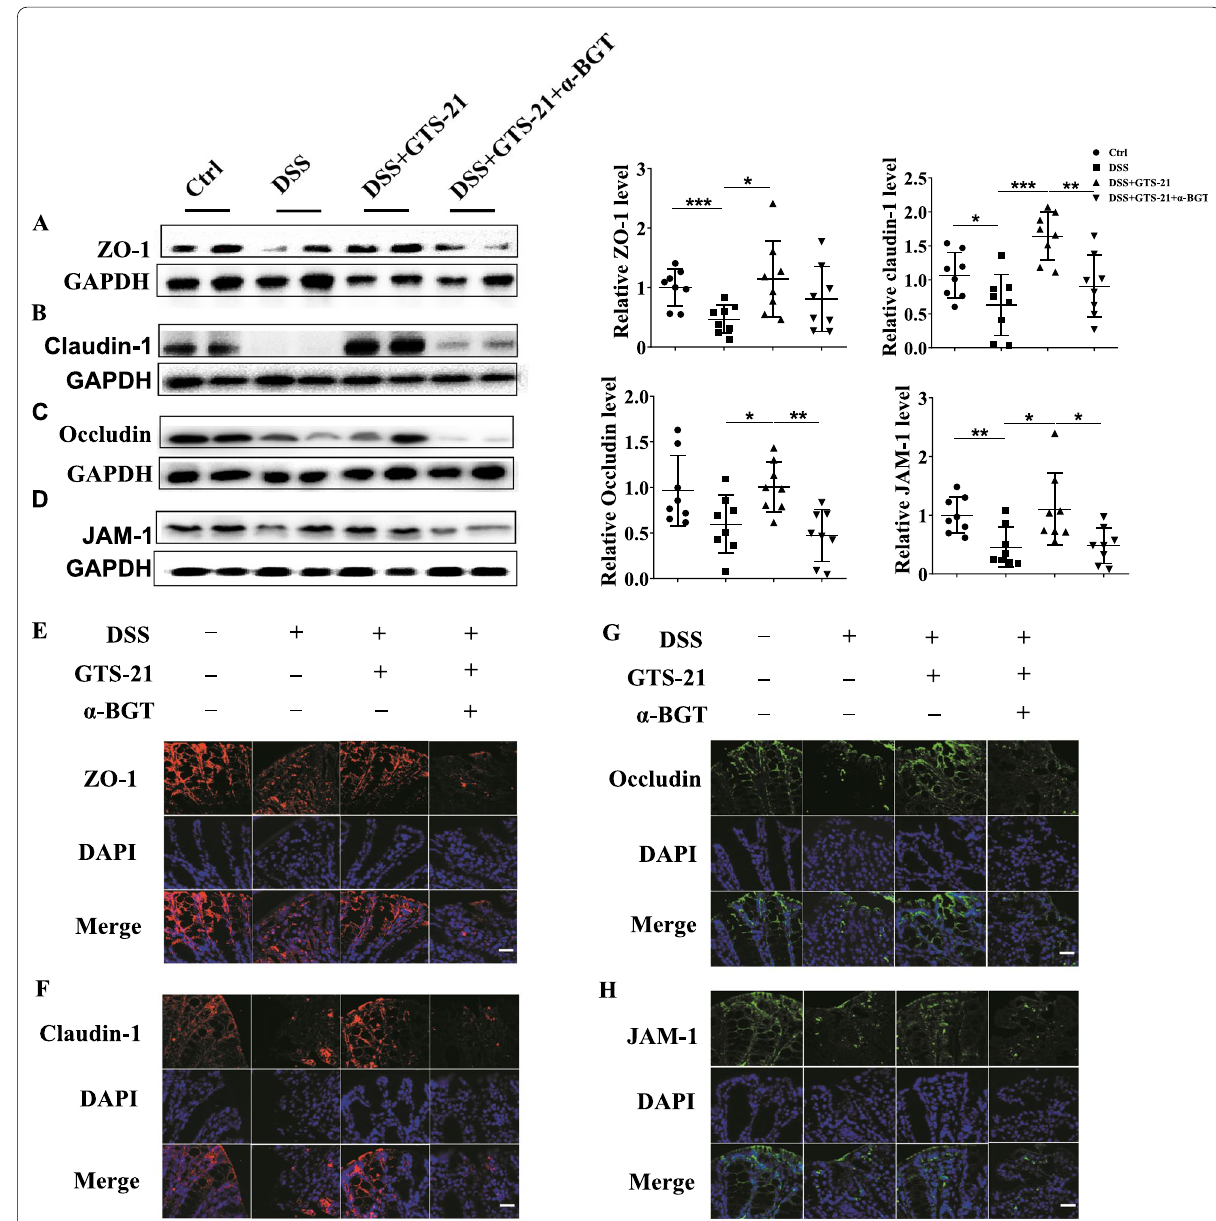
Fig. 3 GTS-21 improves intestinal tight junction (TJ) proteins expressions in DSS-induced colitis. A – D Western blot analysis of mice colonic TJ proteins (ZO-1, claudin-1, occludin, JAM-1) expressions level in different groups. * p < 0.05; ** p < 0.01, *** p < 0.001. E – H Representative immunofluorescence of ZO-1 and claudin-1 (red), occludin and JAM-1 (green) in the proximal colon of mice in Ctrl group (DAPI nuclear staining), DSS group, GTS-21 group and α-BGT pretreatment before GTS-21 group. Magnification, 400. Scale bar, 100 ×